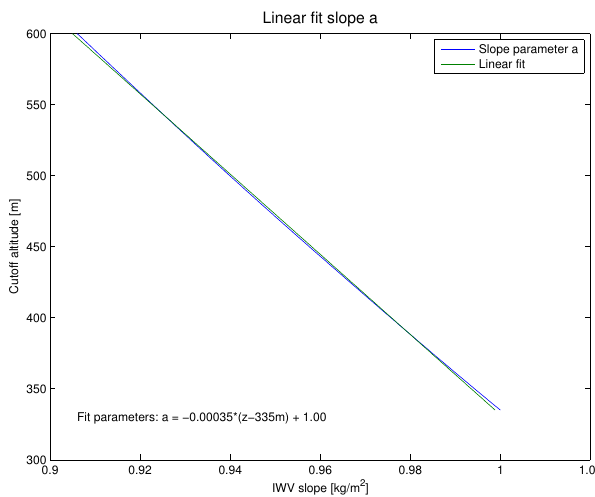
Fig. 4. IWV slope versus lower integration altitude limit, together with a linear fit. As the figure shows, the altitude dependence of the slope can be well approximated by a linear